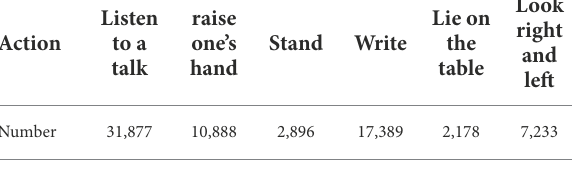
TABLE 3 The amount of data for each behavior category.